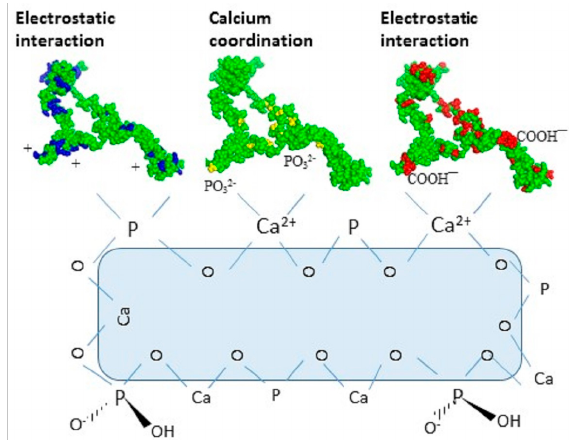
Figure 6. Proposed multimodal interaction mechanisms of OPN with ceramic hydroxyapatite (CHT) resin at pH 6.8. Basic (arginine, histidine and lysine) amino acids of OPN are shown in blue, phosphoryl groups in yellow and acidic (aspartic and glutamic acid) in red.